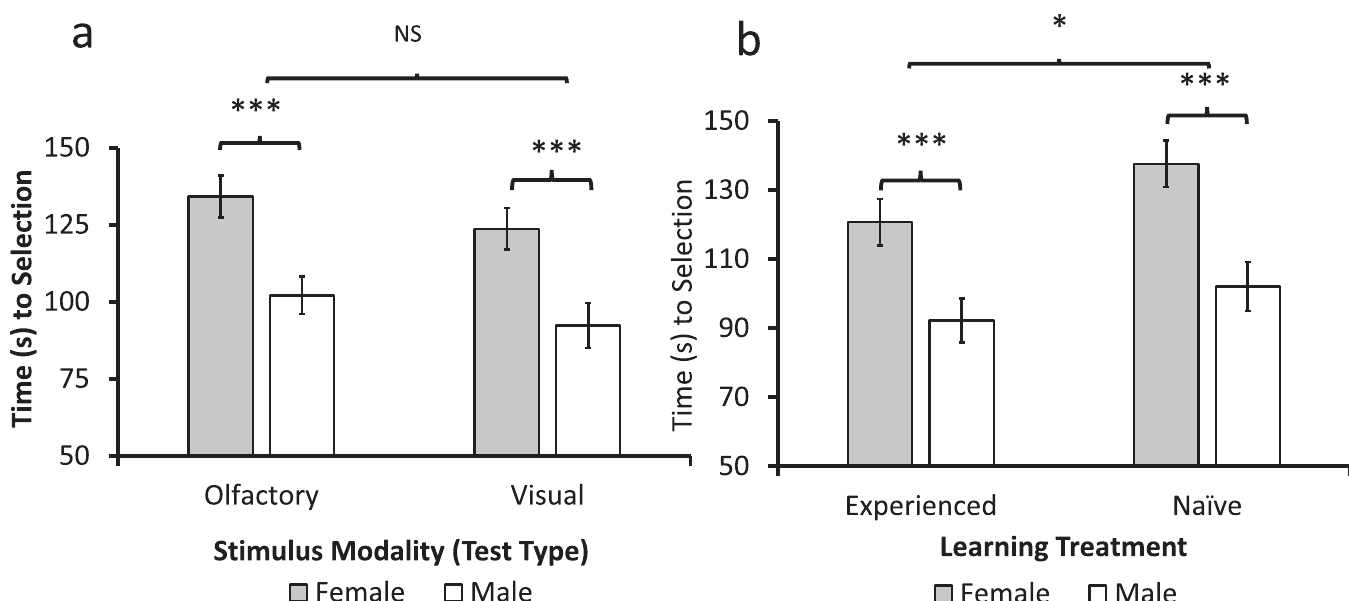
Fig 6. Latency to selection for D . citri . Differences in selection time in female (gray bars) and male (white bars) psyllids based on (a) the stimulus modality of the test (olfactory or visual test) and (b) the learning treatment applied to the insects (na ï ve or experienced). Asterisks ( * ) indicate significant differences * : < 0.05, ** : < 0.01, *** : < 0.001).